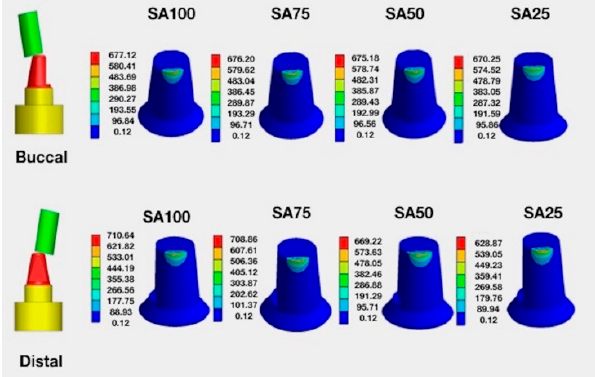
Figure 6. Distribution of stress in zirconia specimens. (Top) The vertical load of 300 N from lingual (L) view. (Bottom) Oblique 10-degree load of 300 N on the lingual marginal ridge. From the left to right are loading models: SA100, SA75, SA50, and SA25.